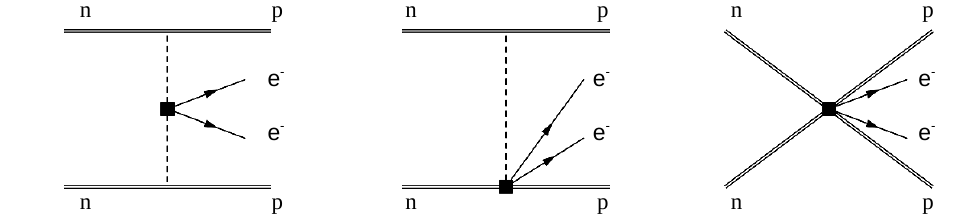
Figure 2 . The di(cid:11)erent contributions of dim-9 LNV operators to the 0 (cid:23)(cid:12)(cid:12) potential, (cid:12)rst discussed in refs. [21, 54{56]. Double, dashed, and single lines denote, respectively, nucleon, pion, and lepton (cid:12)elds. The black square denotes (cid:1) L = 2 (cid:25)(cid:25) , (cid:25)N , and NN operators, discussed in sections 3.1 and 3.2. The remaining vertices are SM interactions between nucleons and